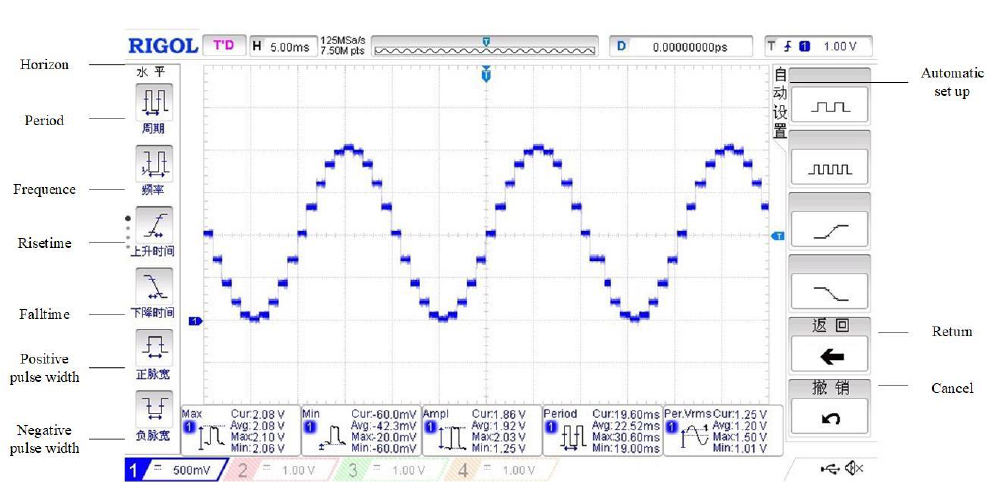
Figure 10. Oscilloscope screenshot of the test result.